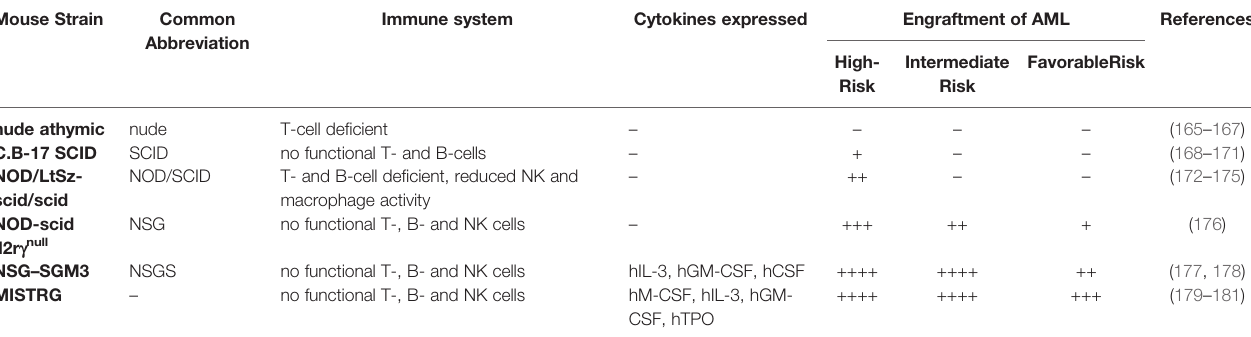
TABLE 4 | Mouse models available for patient-derived xenografts of